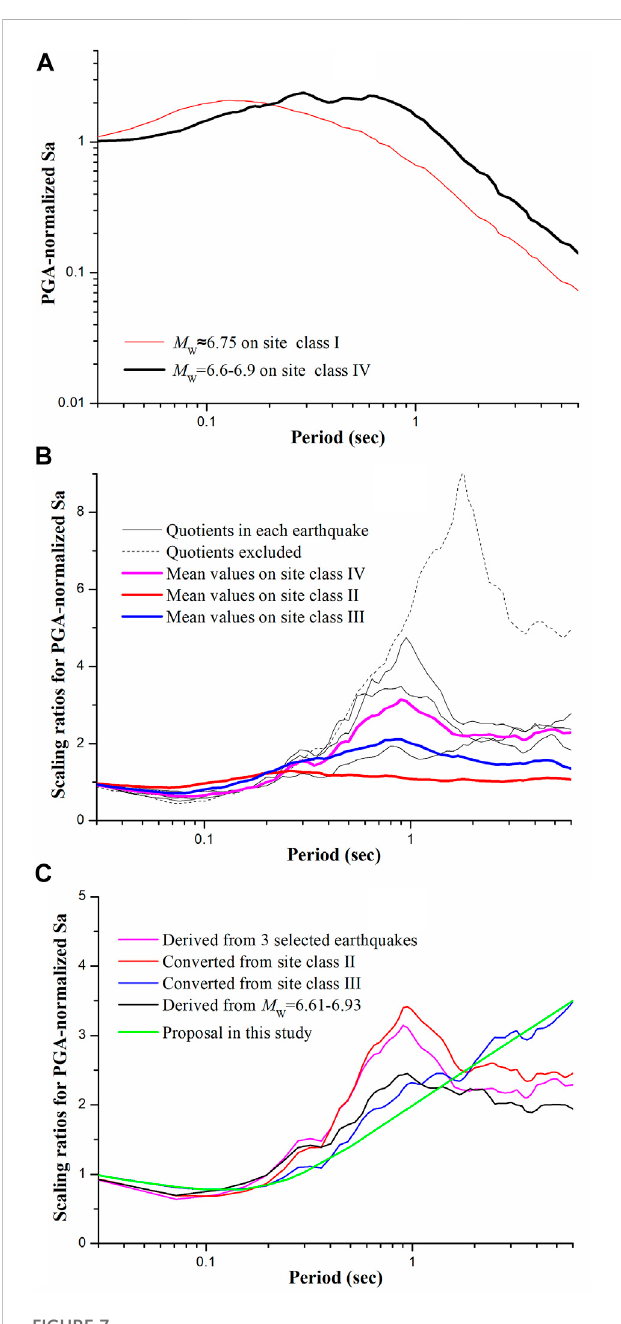
FIGURE 7 Mean values of PGA-normalized Sa on site class IV with moment magnitude M W = 6.61 – 6.93 and on site class I with moment magnitude ≈ 6.75 (A) , the quotients for PGA-normalized Sa on site class IVgiven M W by records in the three selected earthquakes (B) and the indirect conversion (C)